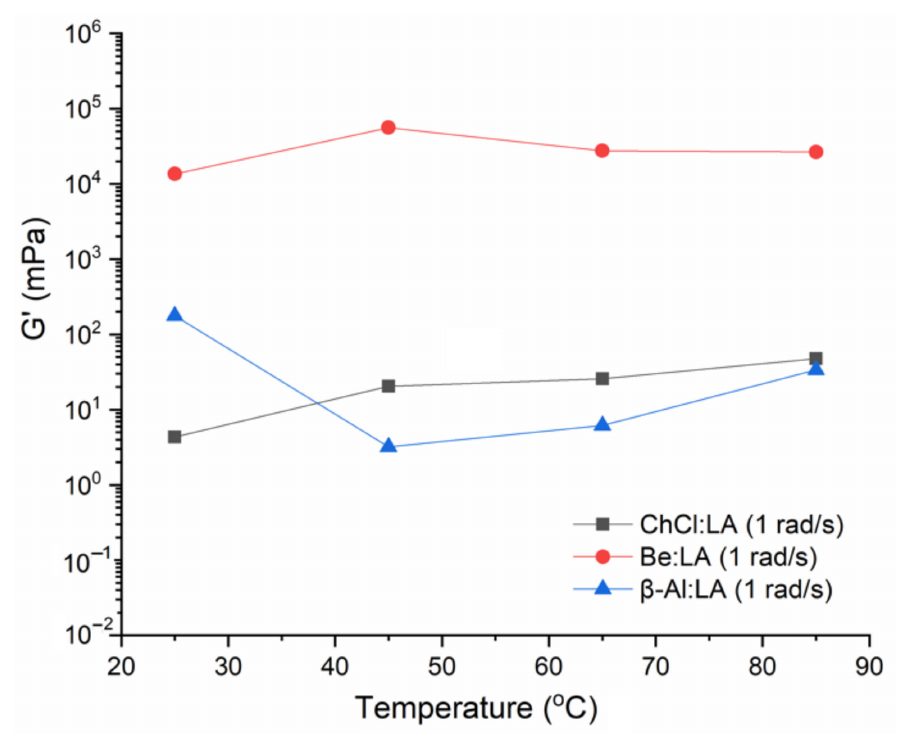
Figure 7. Elastic modulus ( G (cid:48) ) at the low angular frequency at temperatures from 25–85 ◦